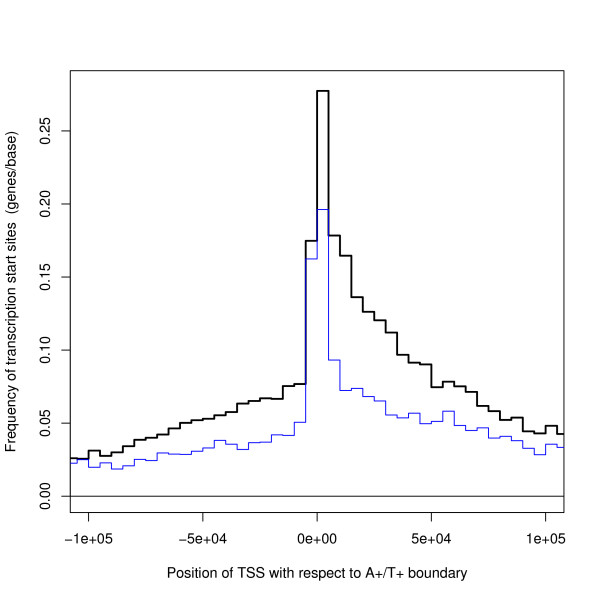
Position of TSS with respect to the A+/T+ boundary – comparison with hybrid genome. The black line shows results for real TSSs in the real genome and the blue line shows the results for the real TSSs in the hybrid genome. Although the lines have a common feature of a central peak, the line for the real genome is higher. The distribution of the positions of the extra TSSs found by the extra segments in the real genome is statistically significant – see Tables 2 and 3.